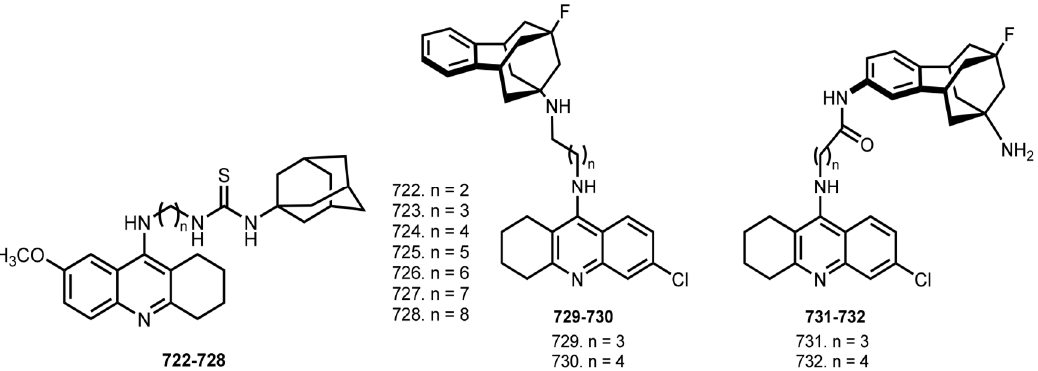
Figure 29. 7 ‐ MEOTA–adamantylamine hybrids 722 – 728 [108], benzohomoadamantane–6 ‐ Cl ‐ THA